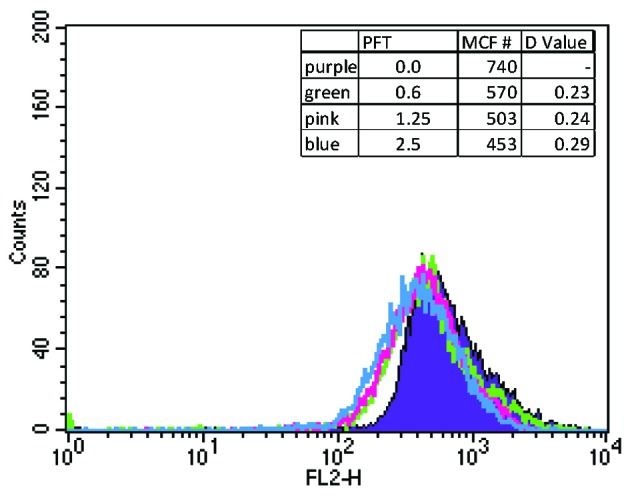
PFT reduces MMP. Tumor cells were cultured with PFT at different concentrations (0, 0.6, 1.25 and 2.5 mg/ml) and the MMP was determined by flow cytometry using TMRE dye. Decrease in TMRE fluorescence indicates loss of membrane potential. PFT depolarized membrane potential in a dose-dependent manner. Statistical analysis was performed by the Kolmogorov-Smirnov test using CellQuest Software System. A D-value >0.2 is considered statistically significant.